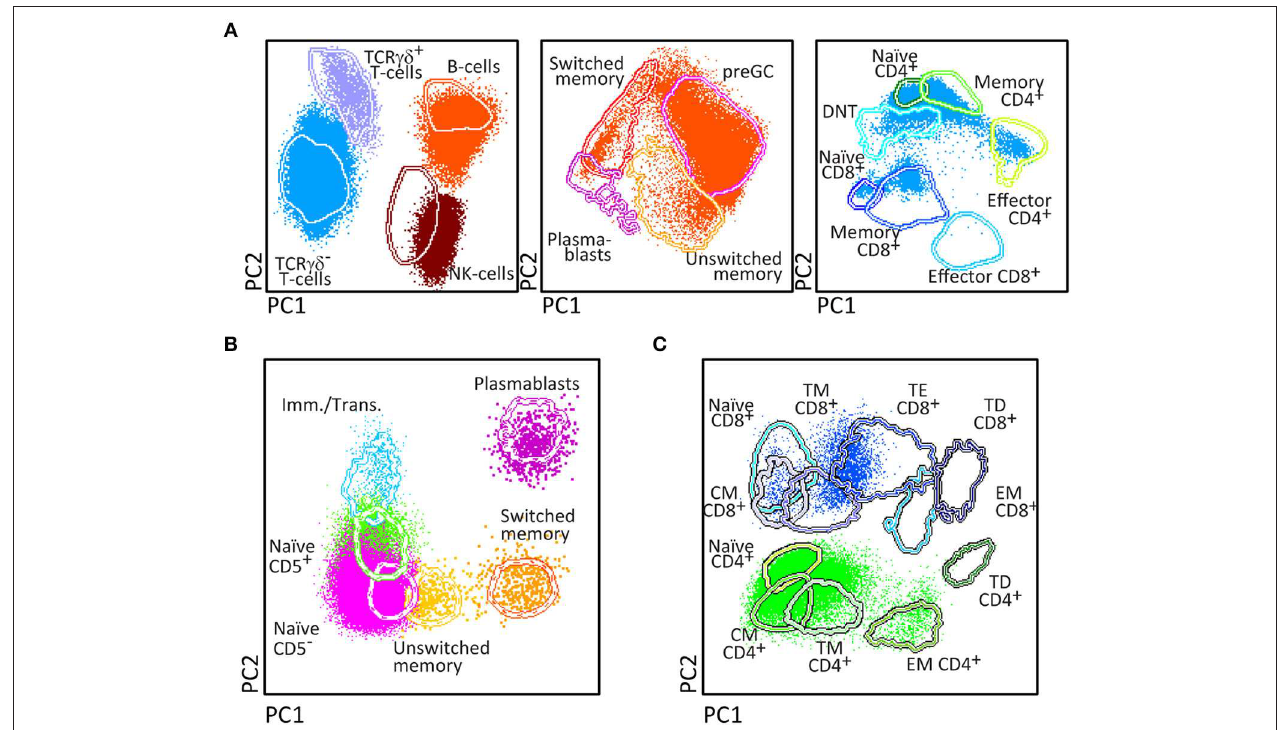
FIGURE 9 | PCA representation of the biologically relevant subsets in a patient diagnosed with a WASp defect (5 years-old). The distribution of the biologically relevant PB lymphocyte subsets has been represented using multidimensional reference plots. The supervised analysis of the PID orientation tube using PC1 vs. PC2 reference plots (A) shows that low numbers of total and naïve CD8 + T-cells, and unswitched and switched memory B-cells, were detected in the patient sample after acquiring 1 × 10 6 cells. Decreased counts of unswitched memory B-cells was confirmed in the analysis of the B-cell tubes (B) . In addition, PCA1 vs. PCA2 representation of the T-cell tube (C) confirmed that naïve CD8 + T-cells were